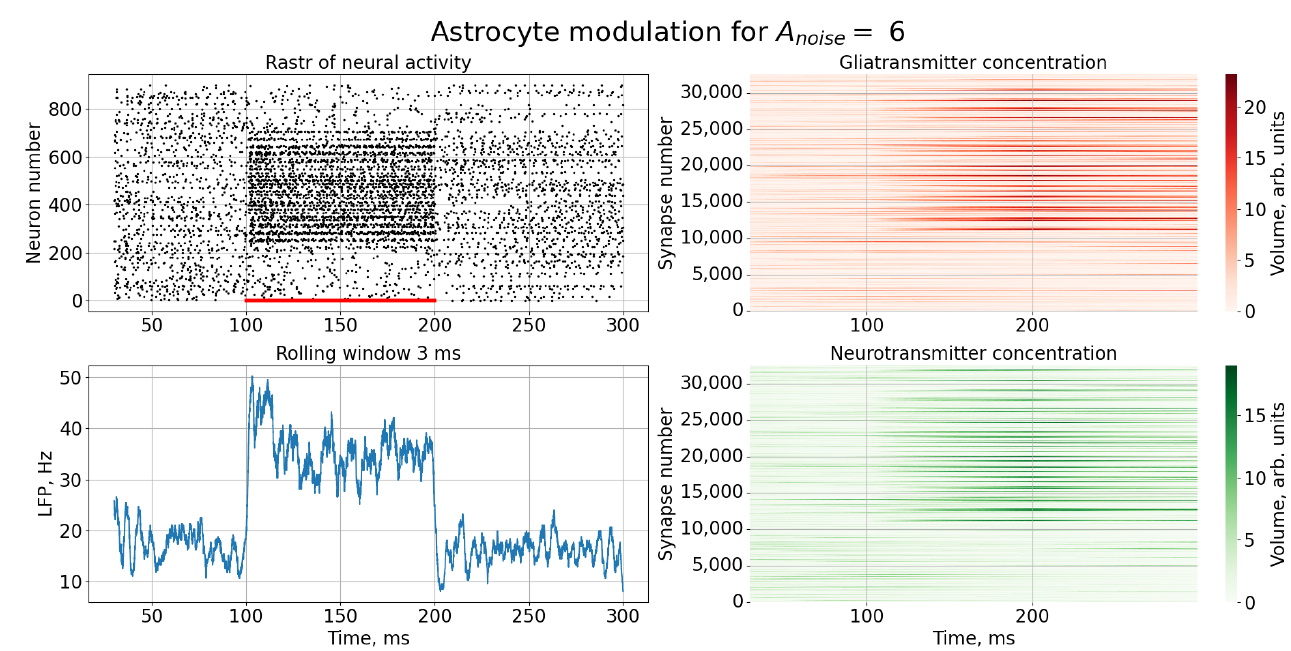
Figure 4. Time series of neural activity (upper left figure in the form of a raster diagram), the corre- sponding LFP signal with rolling window 3 ms (lower left figure) and time series of concentration gliotransmitters (upper right figure) and concentration neurotransmitters (lower right figure) in the case of an external noise signal with A noise = 6 with astrocytic